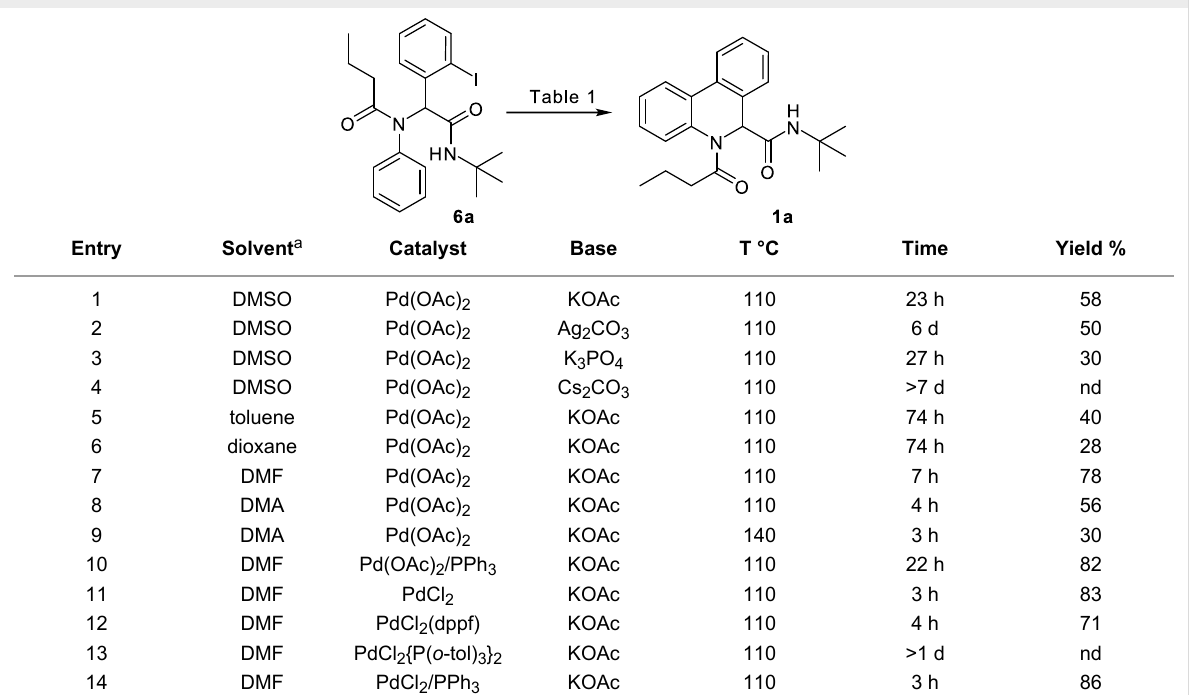
Table 1: Optimization of the direct CH arylation process.